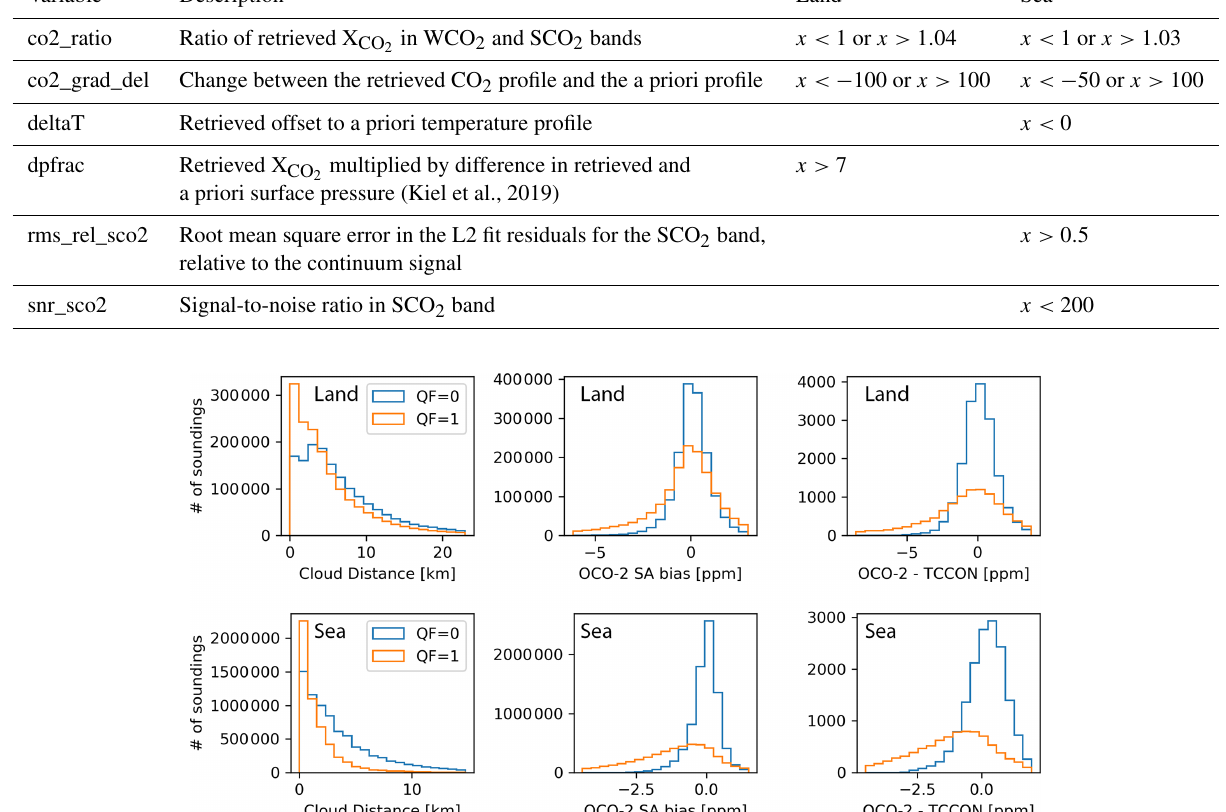
Figure 1. Histogram of data used in this study for nearest-cloud distance (left), small-area (SA) biases (middle), and biases compared to TCCON (right) for soundings over land (top) and sea (bottom). Higher-quality data (QF = 0) are shown in blue, and lower-quality data (QF = 1) are shown in